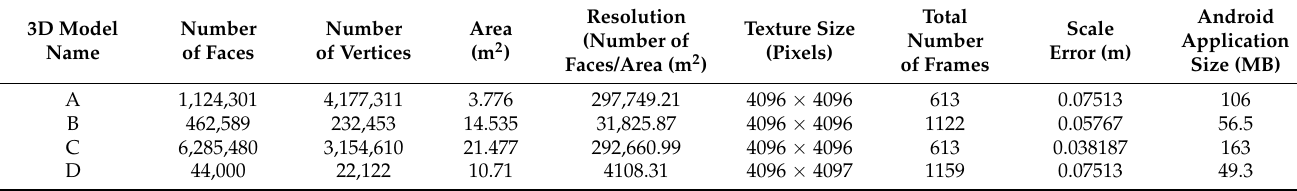
Table 1. Metadata of each 3D model used in the